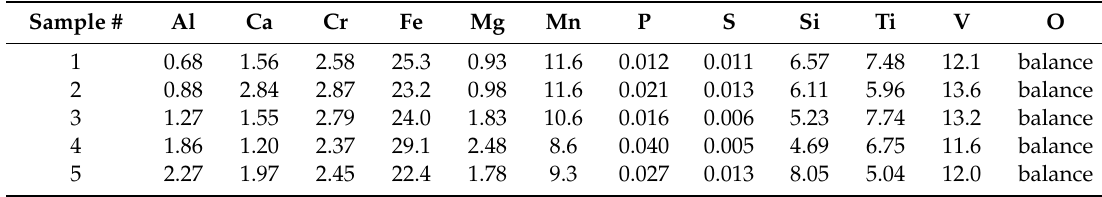
Table 1. The elemental composition of slags studied, wt.